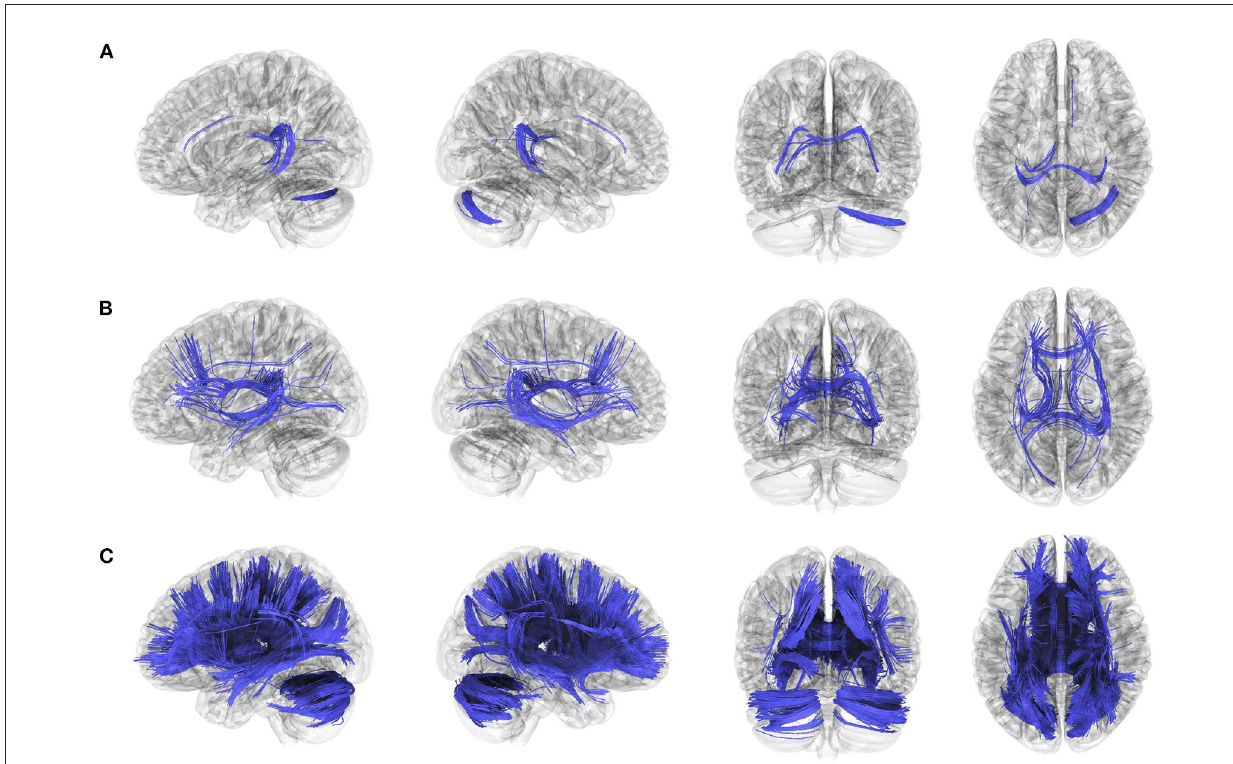
FIGURE2 Decreased anatomical connectivity in bilateral vestibulopathy. (A) The anatomical connectometry analysis found fractional anisotropy (FA) values in the right cerebellum, corpus callosum tapetum, and left fornix decreased in the patients with bilateral vestibulopathy compared with control subjects (FDR ≤ 0.05). (B) The correlation analysis found FA values in the bilateral frontal parahippocampal cingulum, corpus callosum (tapetum, body, and forceps major), right inferior fronto-occipital fasciculus, bilateral fornix, negatively correlated with DHI scores in patients with bilateral vestibulopathy (FDR ≤ 0.05). (C) The correlation analysis found FA values in the corpus callosum (tapetum, body, forceps major, and forceps minor), bilateral fornix, bilateral cerebellum, bilateral superior and anterior thalamic radiation, right inferior fronto-occipital fasciculus, bilateral fronto-parietal cingulum, right dentatoruburothalamic tract negatively correlated with VADL scores in patients with bilateral vestibulopathy (FDR ≤